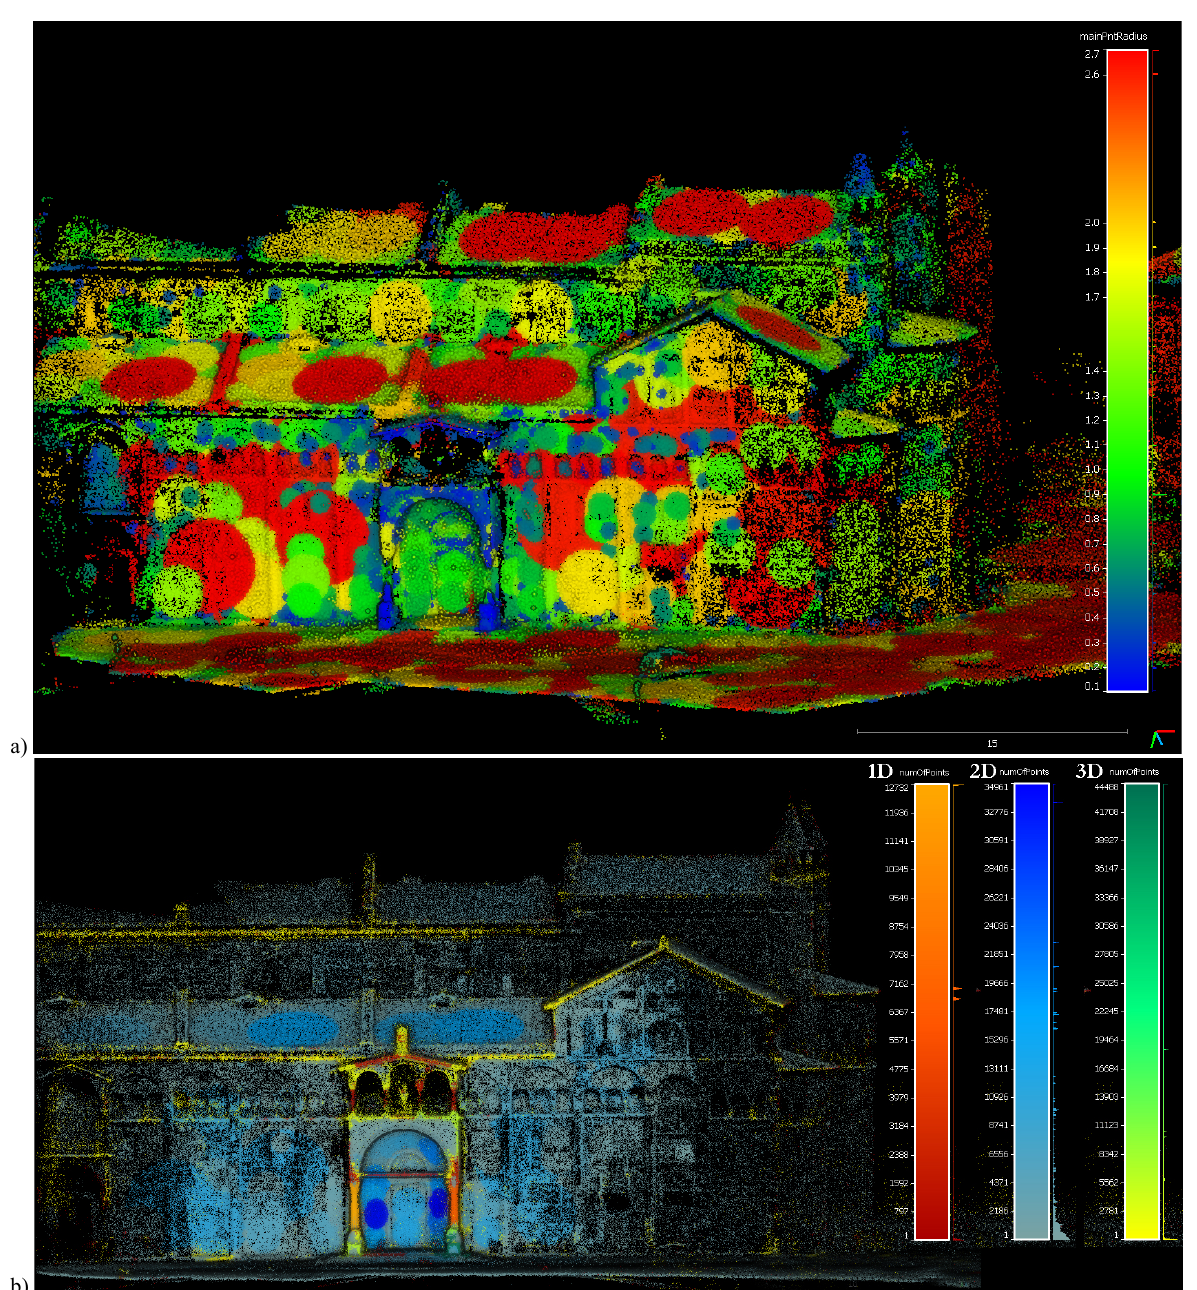
Figure 6: An explicative example of clusters built for the planar (2D) dimensionality class in the range 0.1 – 2.7 meters (a), and the joint visualization of clusters computed for each class (b).